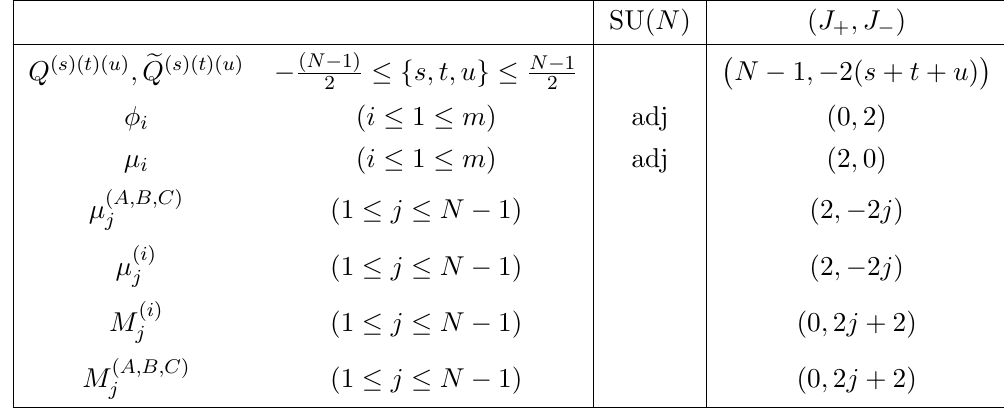
Table 2. Operators in the Higgsed T N